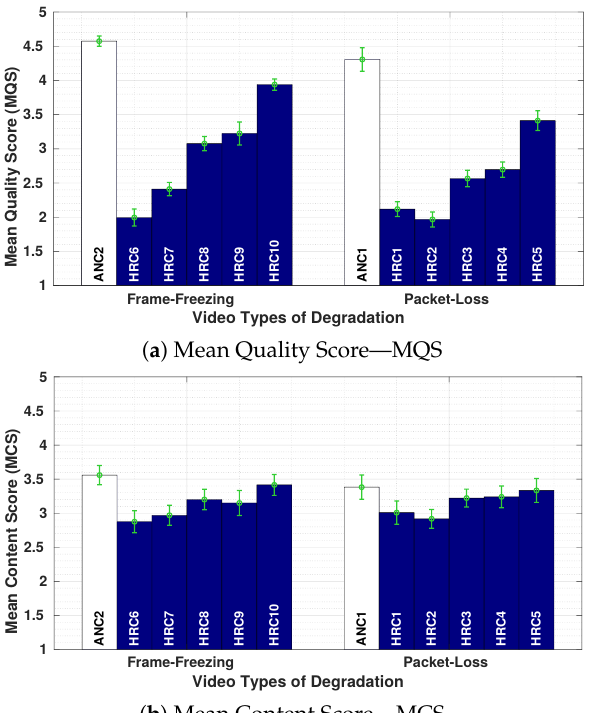
Figure 6. Mean Quality Score (MQS HRC ) and Mean Content Score (MCS HRC ) for the different Hypothetical Reference Circuit (HRC) in Experiment